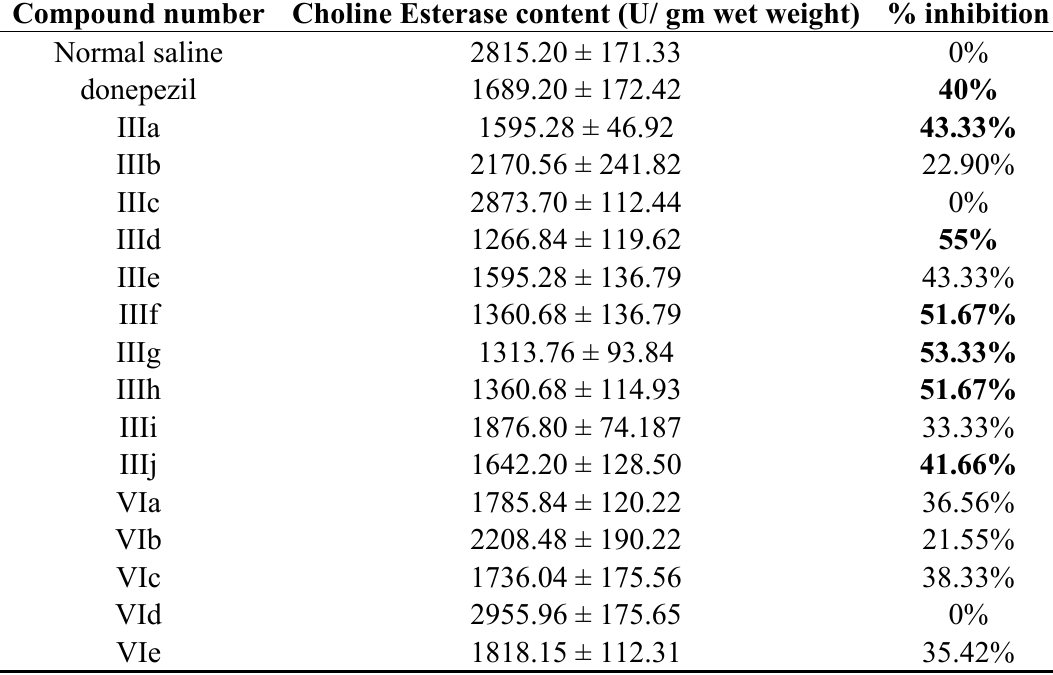
Table1. % Inhibition of AChE activity of donepezil and the synthesized new compounds. Compound